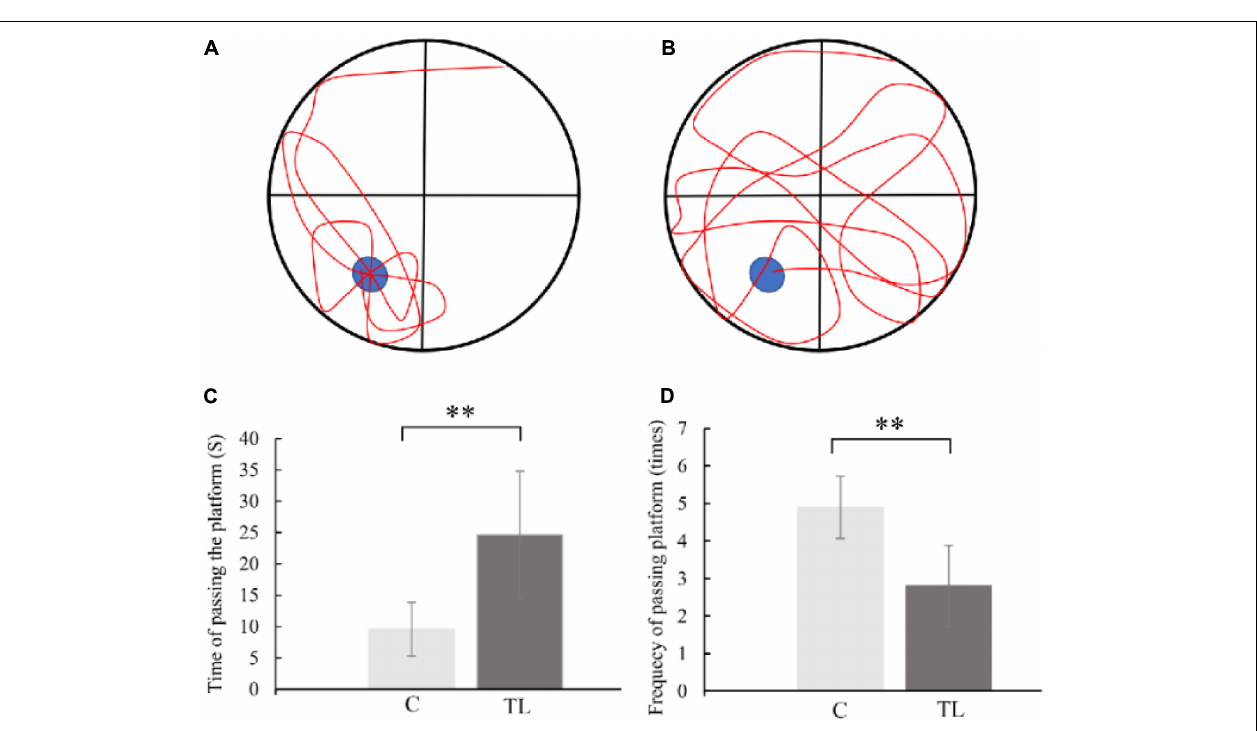
FIGURE 2 | (A) Schematic diagram of C group looking for platform trajectory. The blue circle represents the position of life-saving platform and red represents the trajectory of movement of rats. (B) Schematic diagram of TL group looking for platform trajectory. The blue circle represents the position of life-saving platform and red represents the trajectory of movement of rats. (C) The data are expressed as the mean ± SD, ∗∗ indicates that there is a statistical difference between the two groups ( t -test, ∗∗ P < 0.01). (D) The data are expressed as the mean ± SD, ∗∗ indicates that there is a statistical difference between the two groups ( t -test, ∗∗ P <